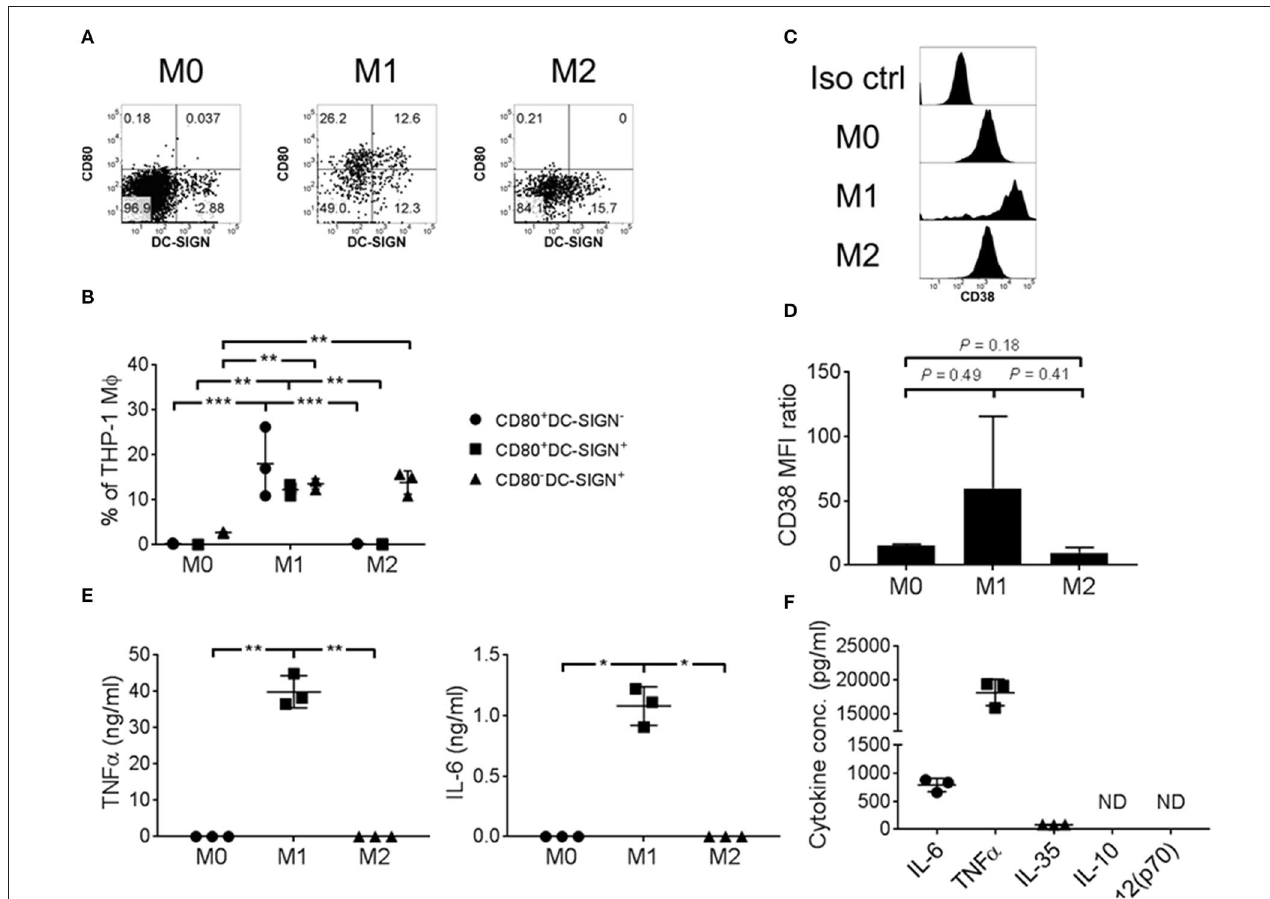
FIGURE 3 | THP-1 derived M1 macrophages expressed CD38 and secreted pro-inflammatory cytokines. THP-1 cells were polarized into M0/M1/M2 macrophages with differential surface expression of (A,B) CD80 and/or DC-SIGN; (C,D) CD38. Representative flow cytometry data are shown. MFI: geometric mean fluorescent intensity. (E) IL-6 and TNF α cytokine secretion, as determined by ELISA using culture supernatant. The data represents the means ± s.d. (F) Cytokine secretion profile of M1 macrophages, as determined by ELISA using culture supernatant. ND: not detected. * P ≤ 0.05; ** P ≤ 0.01; *** P ≤ 0.001.